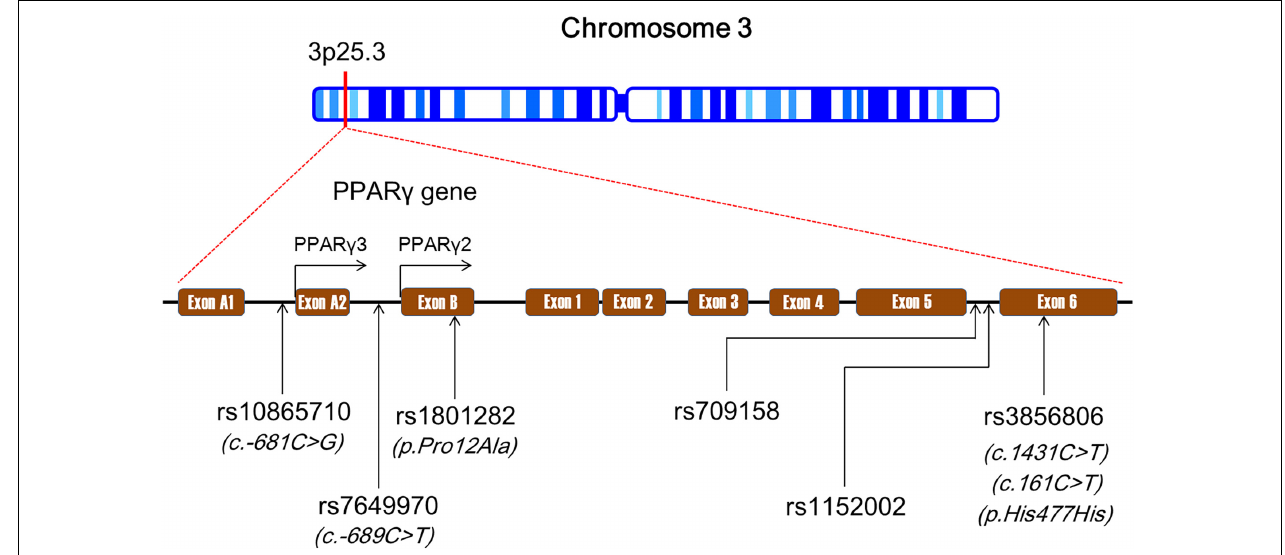
FIGURE 1 | The genomic landscape of single-nucleotide polymorphisms (SNPs) in peroxisome proliferator-activated receptor gamma gene ( PPARG ). SNPs, single-nucleotide polymorphisms; PPARG , peroxisome proliferator-activated receptor gamma gene.